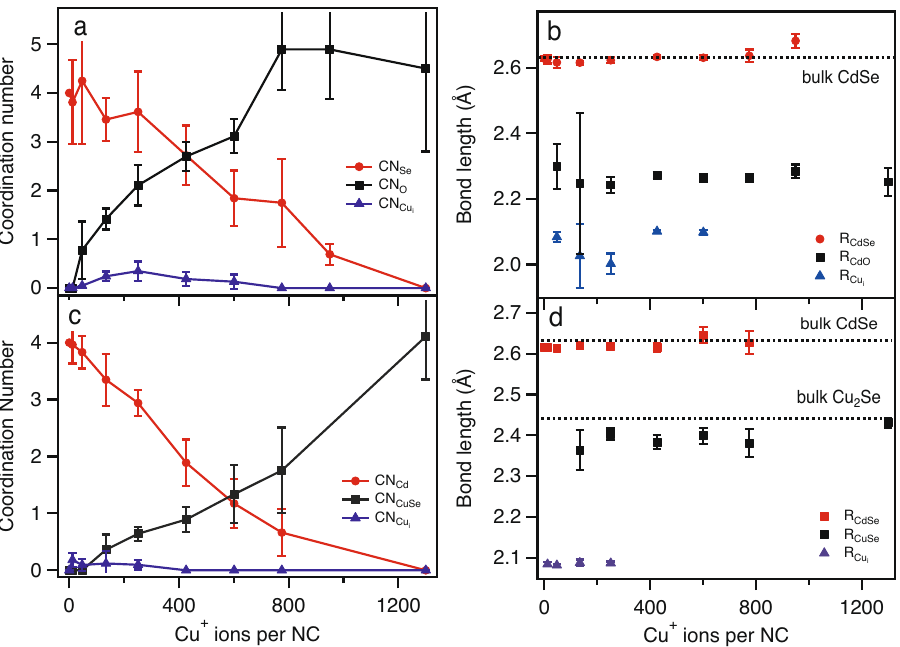
Fig. 4 Change in coordination numbers and bond lengths as a function of copper concentration. Values of the coordination numbers and bond lengths from fi ts of the Cd K-edge ( a , b ) and Se K-edge ( c , d ) EXAFS data for 5.0 nm CdSe at various stages of the copper cation exchange reaction. The error bars represent uncertainties in the EXAFS fi tting, and speci fi c details on how these errors are calculated can be found in Ref. 33